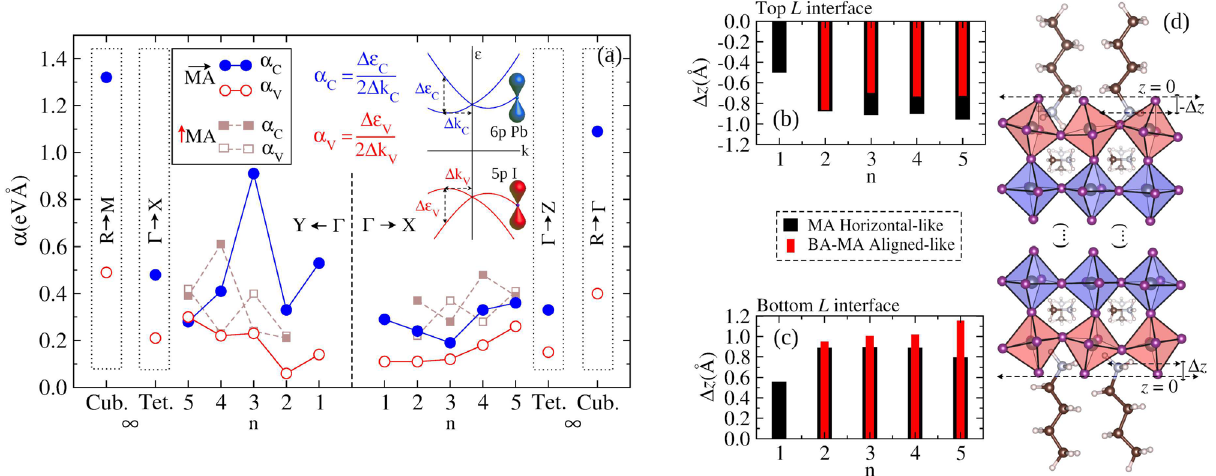
Figure 5. ( a ) Rashba splitting for parabolic bands throughout Y ← Ŵ and Ŵ → X branches for VBM ( α V ) and CBM ( α C ) for BA 2 MA n − 1 Pb n I 3 n + 1 with respect to n layers and for orthorhombic, tetragonal, and cubic bulks (from paths indicated in dotted rectangles). The schematic representation of Rashba splitting and its definition as α = �ε/ 2 � k used in the calculation. Penetration degree ( (cid:31) z ) of BA spacers in the Pb n I 3 n + 1 inorganic layer for the top ( b ) and bottom ( c ) interfaces based on the scheme in ( d ). (cid:31) z for both MA horizontal-like and BA-MA aligned-like configurations were calculated conventionally by taking � z < 0 for top and � z > 0 for